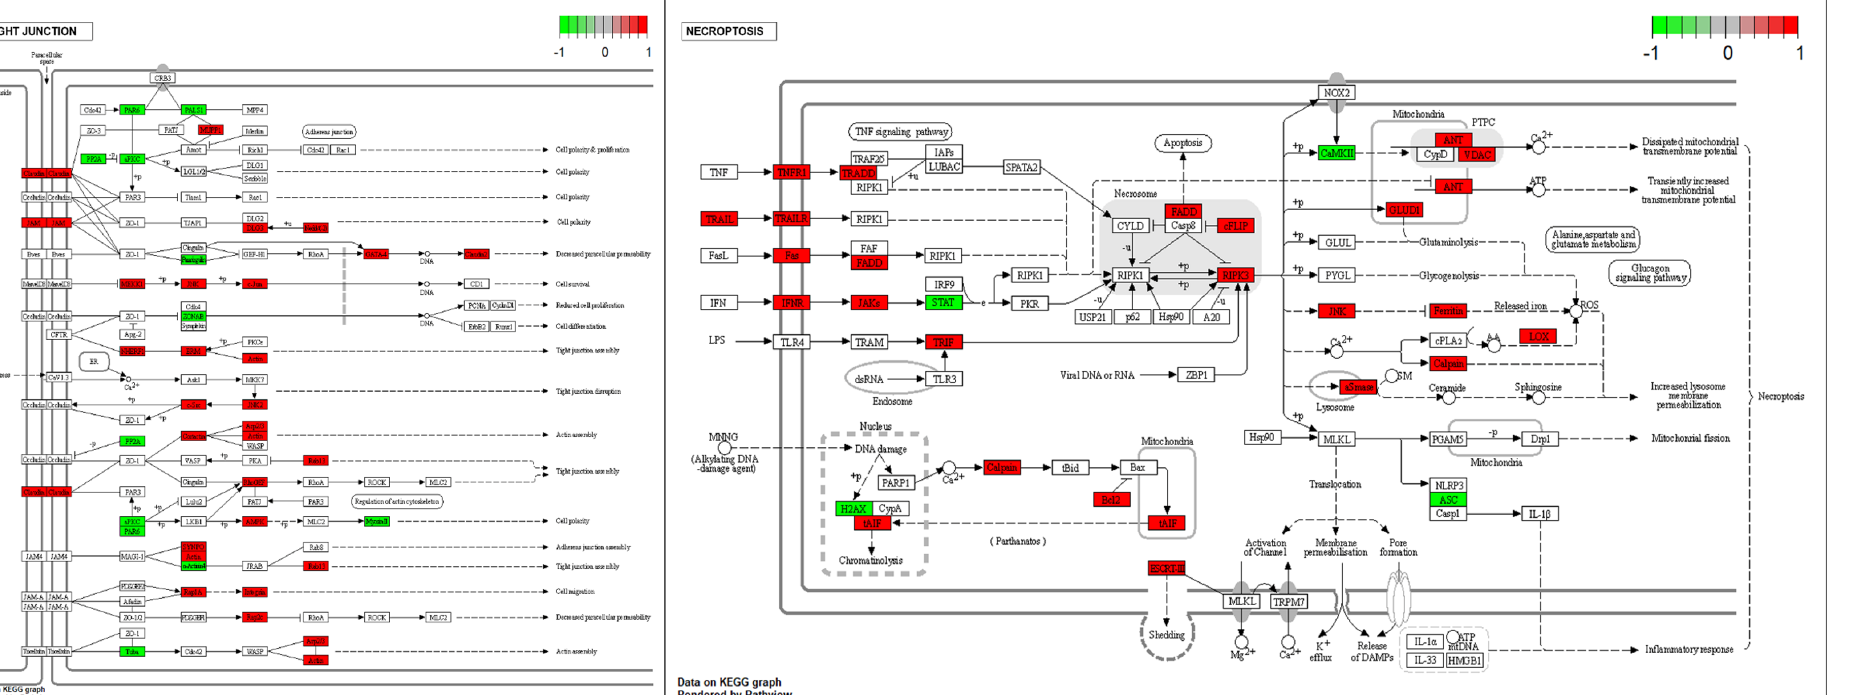
Figure 5. The expression pattern of DEGs involved in the tight junction and the necroptosis pathways. The DEGs were mapped by R package pathview. The box color represents the different regulations of genes with log FC value (red; upregulation, green; downregulation).